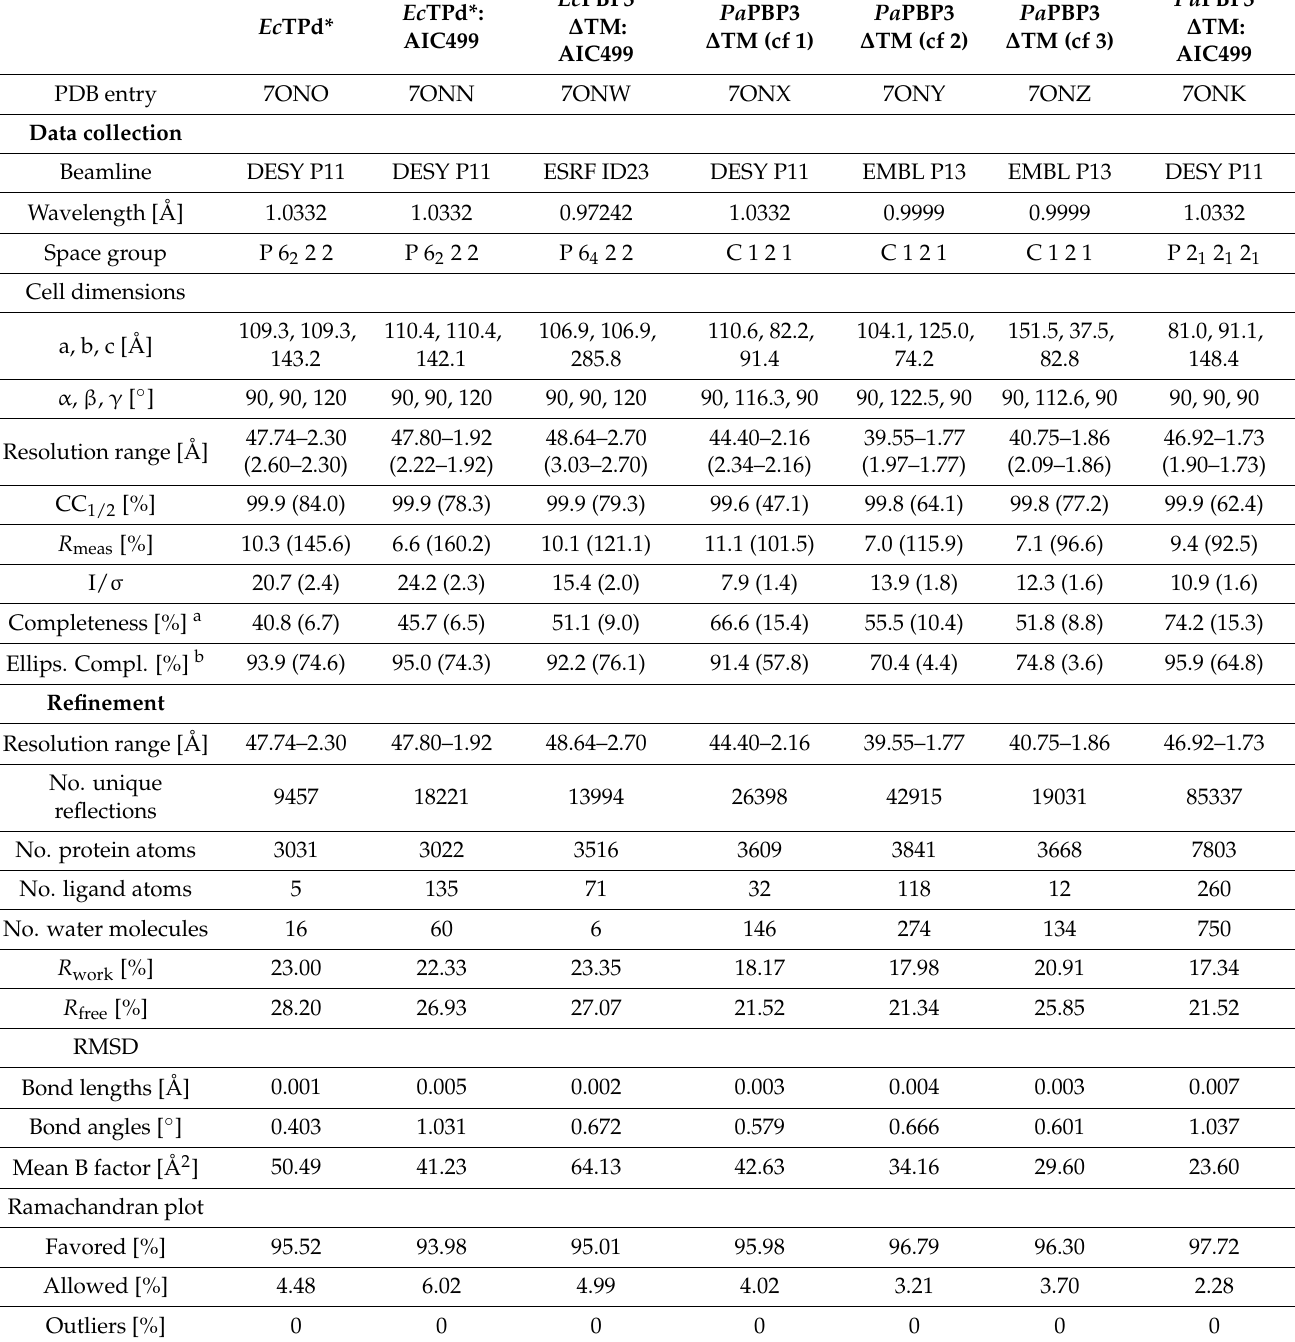
Table 1. Data collection and refinement statistics of PBP3 structures reported in this paper (cf, crystal form). Values in parentheses refer to the highest-resolution